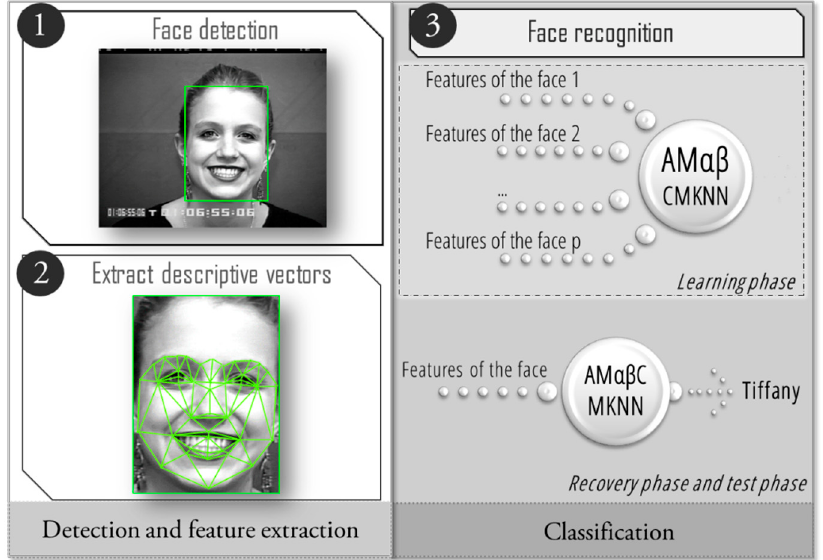
Figure 2. General process for face recognition using Am αβ - correlation matrix K-nearest neighbor (CMKNN).